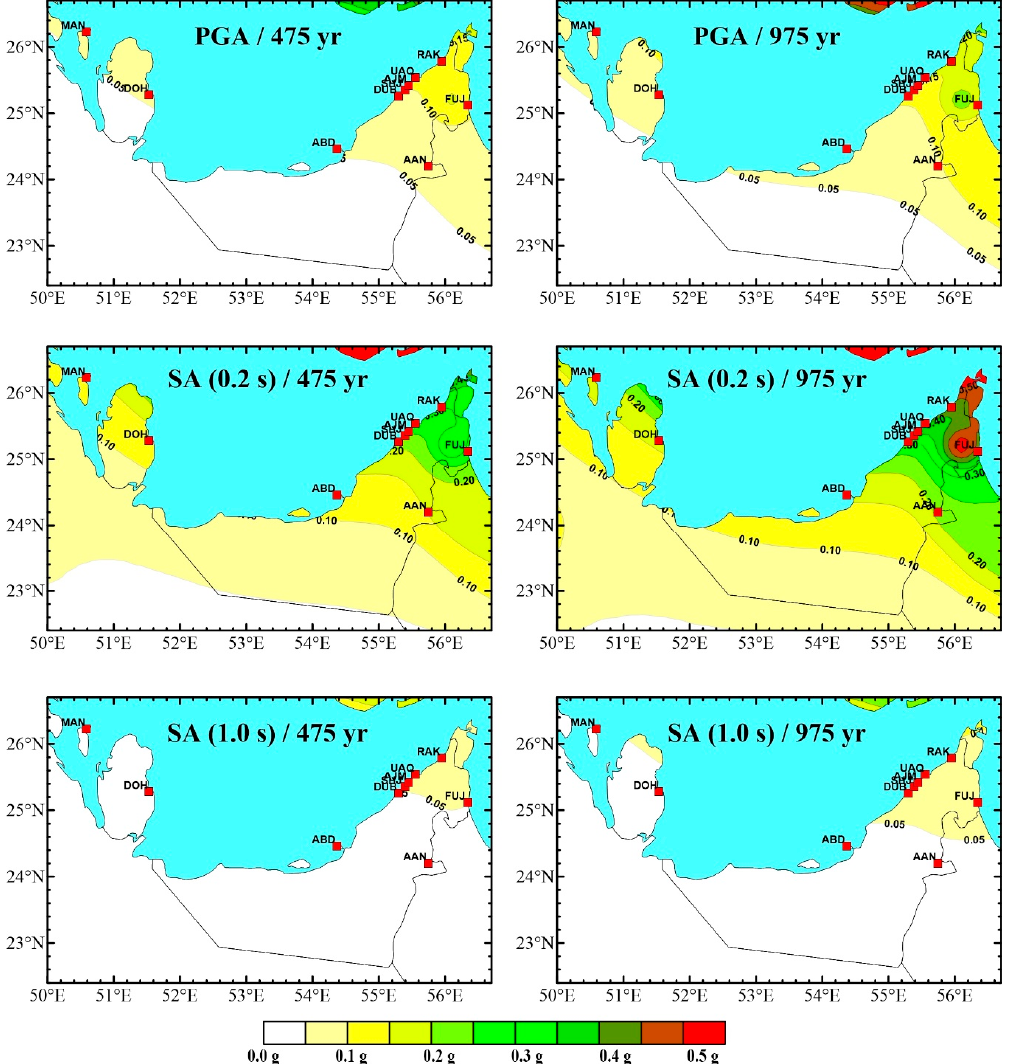
Figure 6. Seismic-hazard maps, for B/C NEHRP boundary site conditions, depicting the mean PGA and spectral accelerations [SA (0.2 s), and SA (1.0 s)] for return periods of 475 and 975 years [AAN, Al-Ain, ABD, Abu Dhabi; AJM, Ajman; DOH, Doha; DUB, Dubai; FUJ, Fujaira; MAN, Manama; RAK, Ras Al-Khaimah; SHJ, Sharjah; UAQ, Umm Al-Quwain].